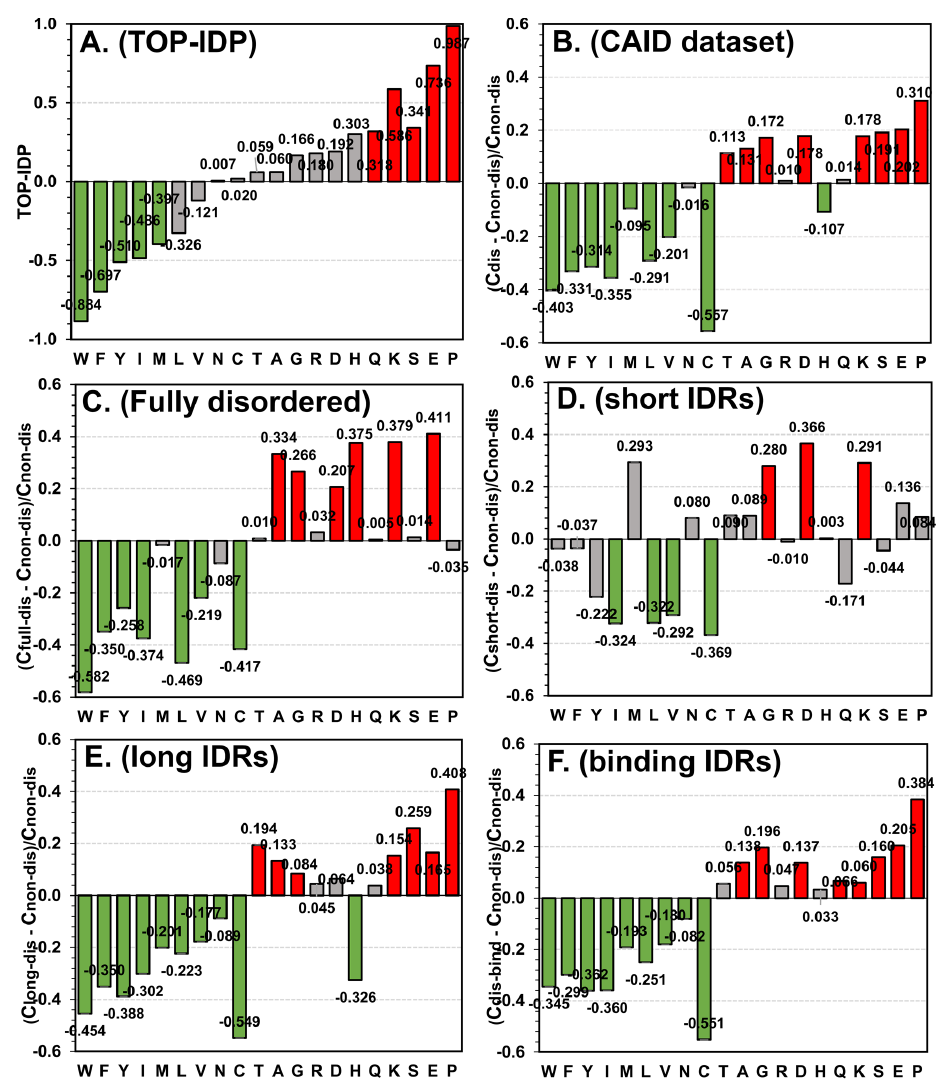
Figure 1. Compositional bias of intrinsic disorder measured for different collections of disordered proteins and regions . ( A ) TOP-IDP scale; ( B ) CAID dataset; ( C ) fully disordered proteins in CAID; ( D ) short IDRs in CAID; ( E ) long IDRs in CAID; and ( F ) disordered binding regions in CAID. The amino acids on the x axis are sorted according to the TOP-IDP scale in the way that is consistent with the original article (data for panel A was adapted from Ref. [15]), from the most order promoting to the most disorder promoting. The propensities are color-coded where green denotes statistically significant depletion; red denotes statistically significant enrichment; and gray denotes that the difference is not statistically significant at the p -value of 0.05. Values of the disorder propensities are shown at the top of the bars.